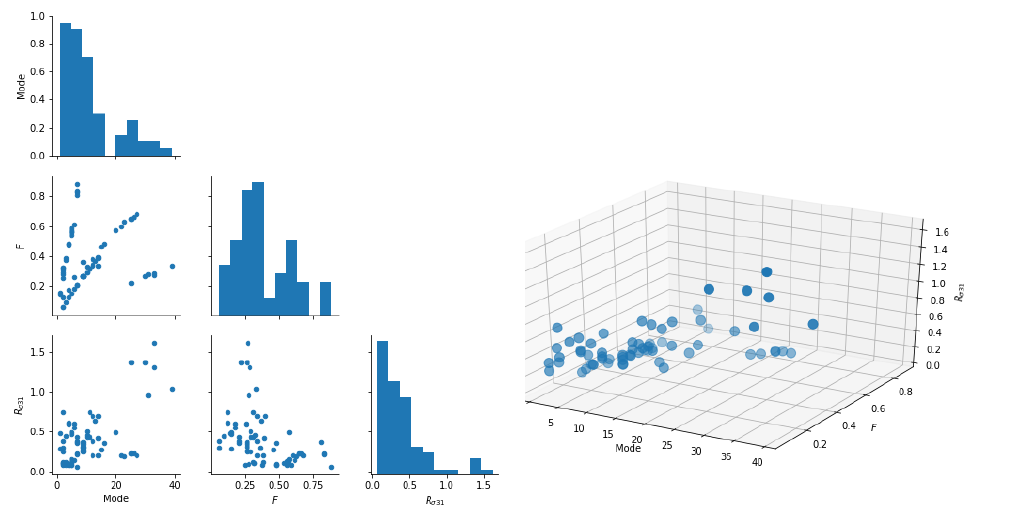
Figure 5. Scatter plots and histograms for the parameters selected in Section 2: the oscillation mode, stress ratio ( R σ 31 = max ( std ( σ 3 )) / max ( std ( σ 1 )) ), and relative bending stiffness ratio ( F = f n , b / f n , tot